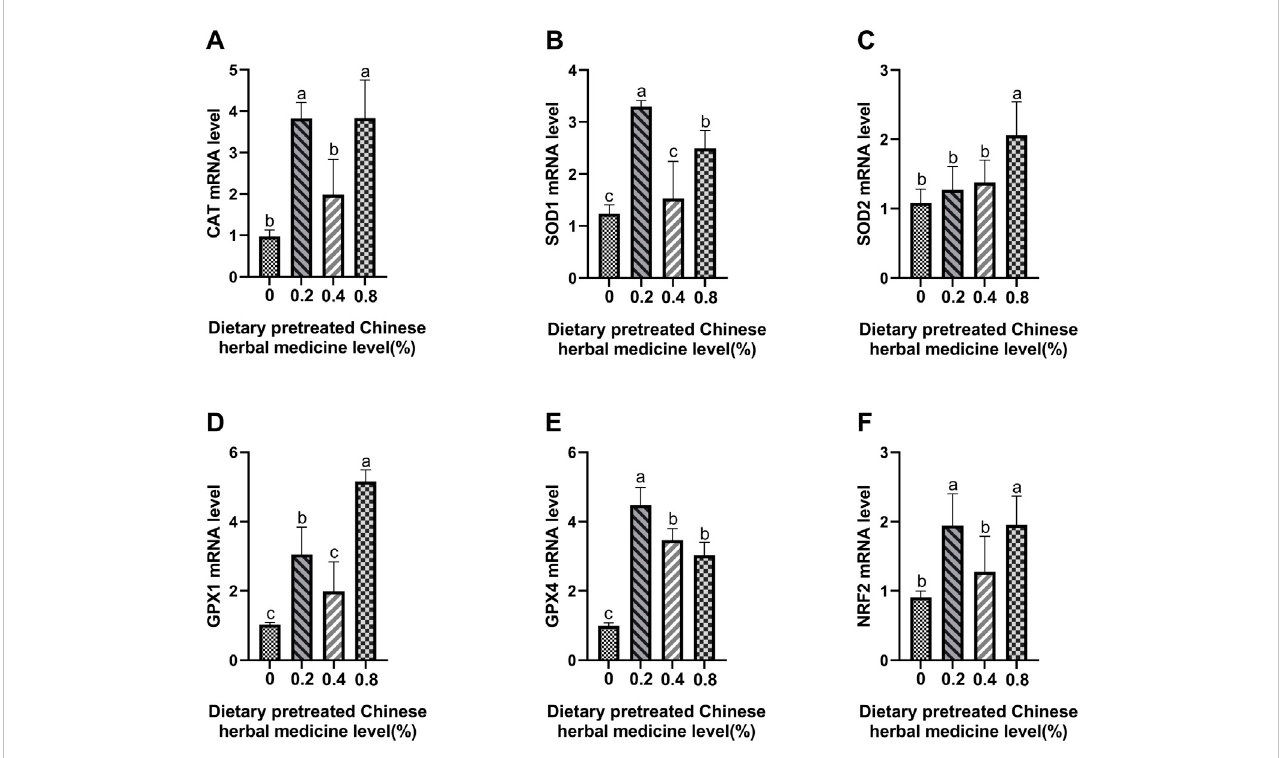
FIGURE 7 EffectsofdietaryPCHMsupplementationonantioxidation-relatedmRNAexpressioninmagnum.Theeffectofaddingnaturalherbs(0,0.2%,0.4%,0.8%) indiets inthemagnum,measured byquantitative PCR: (A) CAT , (B) SOD1 , (C) SOD2 , (D) GPX1 , (E) GPX4 ,and (F) Nrf2 . Values are expressed as means± SEM of six birds per treatment. Means without a common letter differ ( p <